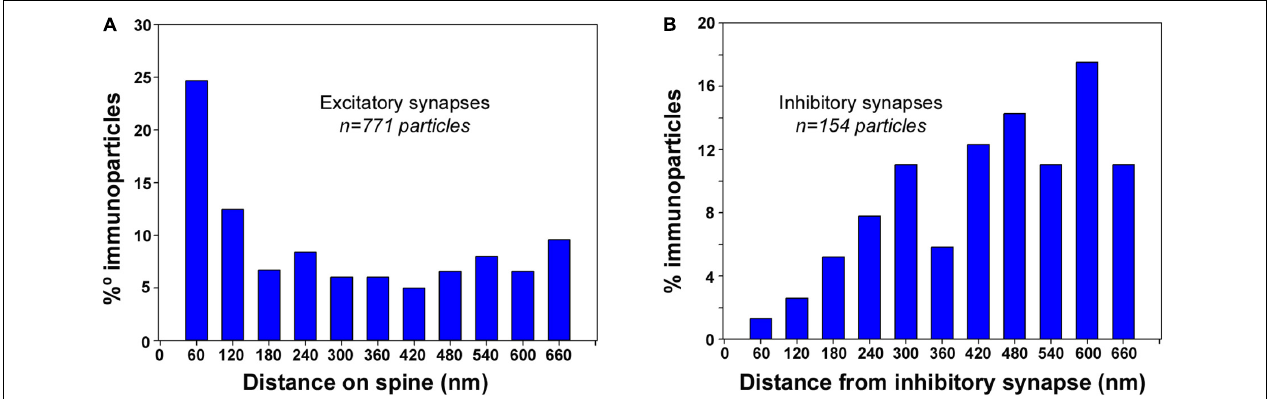
FIGURE 7 | Synapse-dependent association of SK2 channels. Distribution of SK2 immunoparticles relative to the neurotransmitter release sites. Immunoparticles were recorded in 60-nm-wide bins along the extrasynaptic plasma membrane. Data are expressed as the proportion of immunoparticles at a given distance from the edge of the synaptic specialization. (A) Histogram showing the 3D distribution of immunoparticles for SK2 around asymmetrical synapses on spines of CA1 pyramidal cells. This data shows an enrichment of SK2 in the proximity of asymmetrical synapses on spines. (B) Histogram showing the 3D distribution of immunoparticles for SK2 around symmetrical synapses on dendritic shafts of CA1 pyramidal cells. This data suggests no association of SK2 with symmetrical synapses on